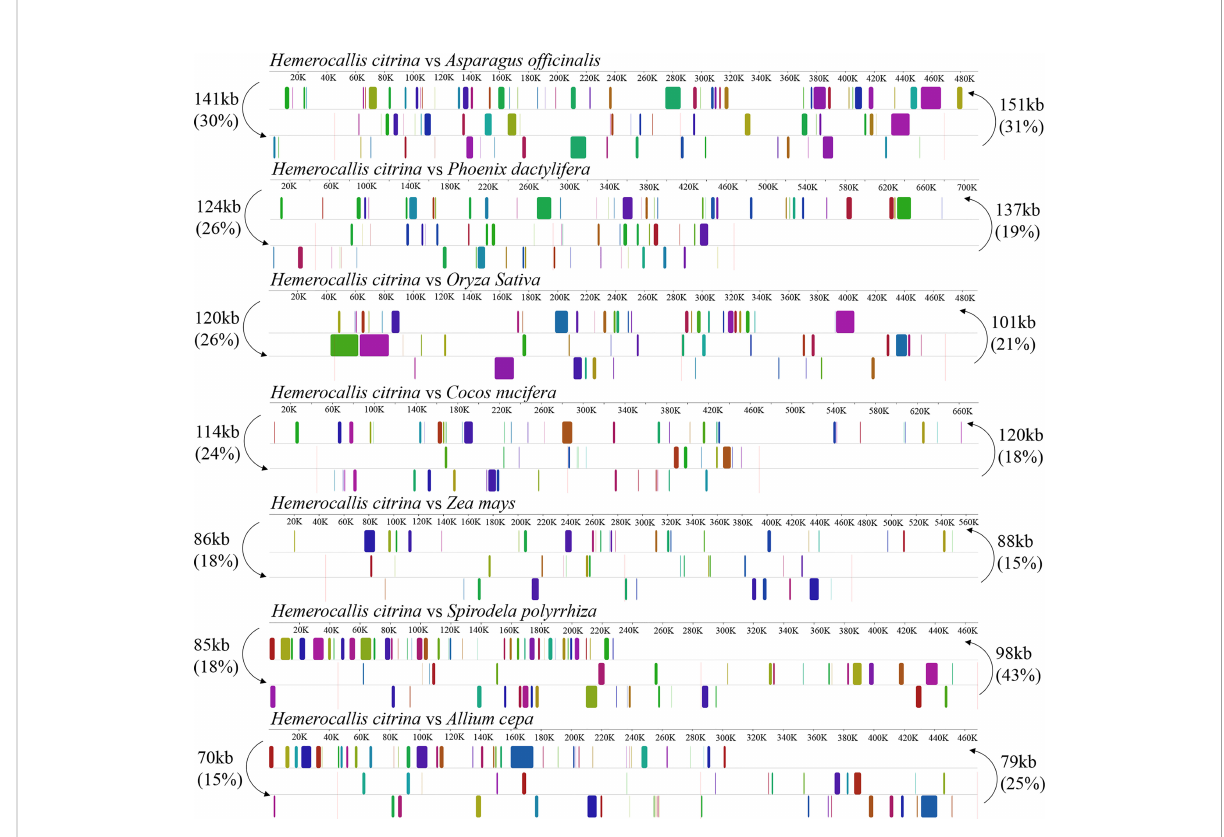
FIGURE 2 Synteny blocks and shared mtDNA of the H. citrina and seven other monocotyledons based on Mauve alignments. Left arrows indicate the amount of shared mtDNA, in kb and percentage, of the H. citrina and one other species, and right arrows present the reciprocal